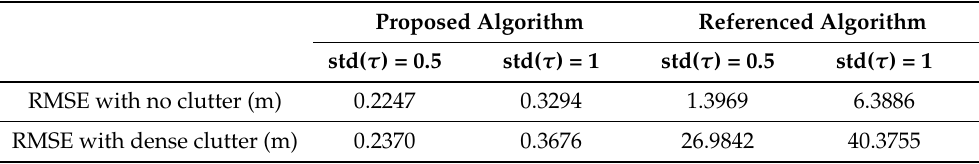
Figure 10. Comparison with the referenced algorithm in [45]. Table 1. RMSE of simulation